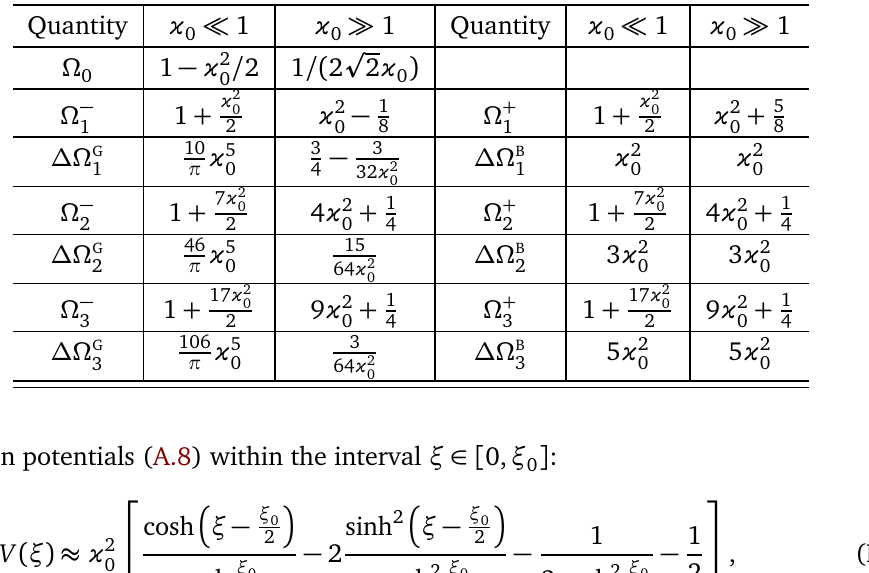
Table 1: Asymptotic behaviour of the band boundaries: Only the leading terms in (cid:99) are presented. Here Ω is width of the main gap, Ω − and Ω + denote the bottom ν ν 0 0 = Ω + − Ω − and the top edges of the ν -th gap with ν ∈ (cid:78) . The notations ∆Ω G and ν ν ν ∆Ω B = Ω − − Ω + are introduced for the widths of the ν -th gap and the conductance ν ν ν − 1 = Ω − = Ω band, respectively (we define Ω + 0 0 0